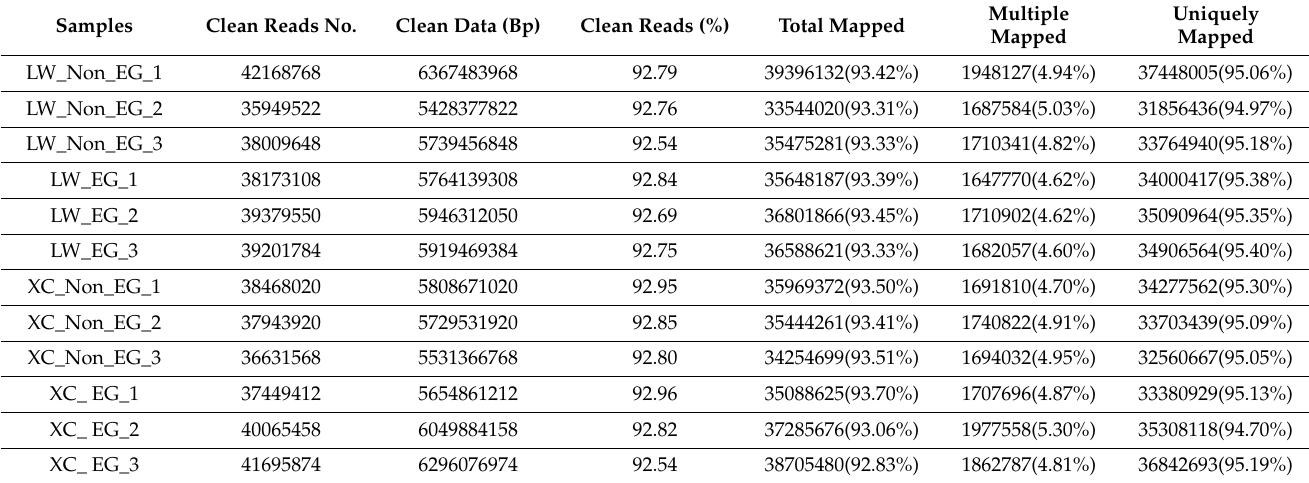
Table 1. Data filtering and comparison analysis of raw reads.